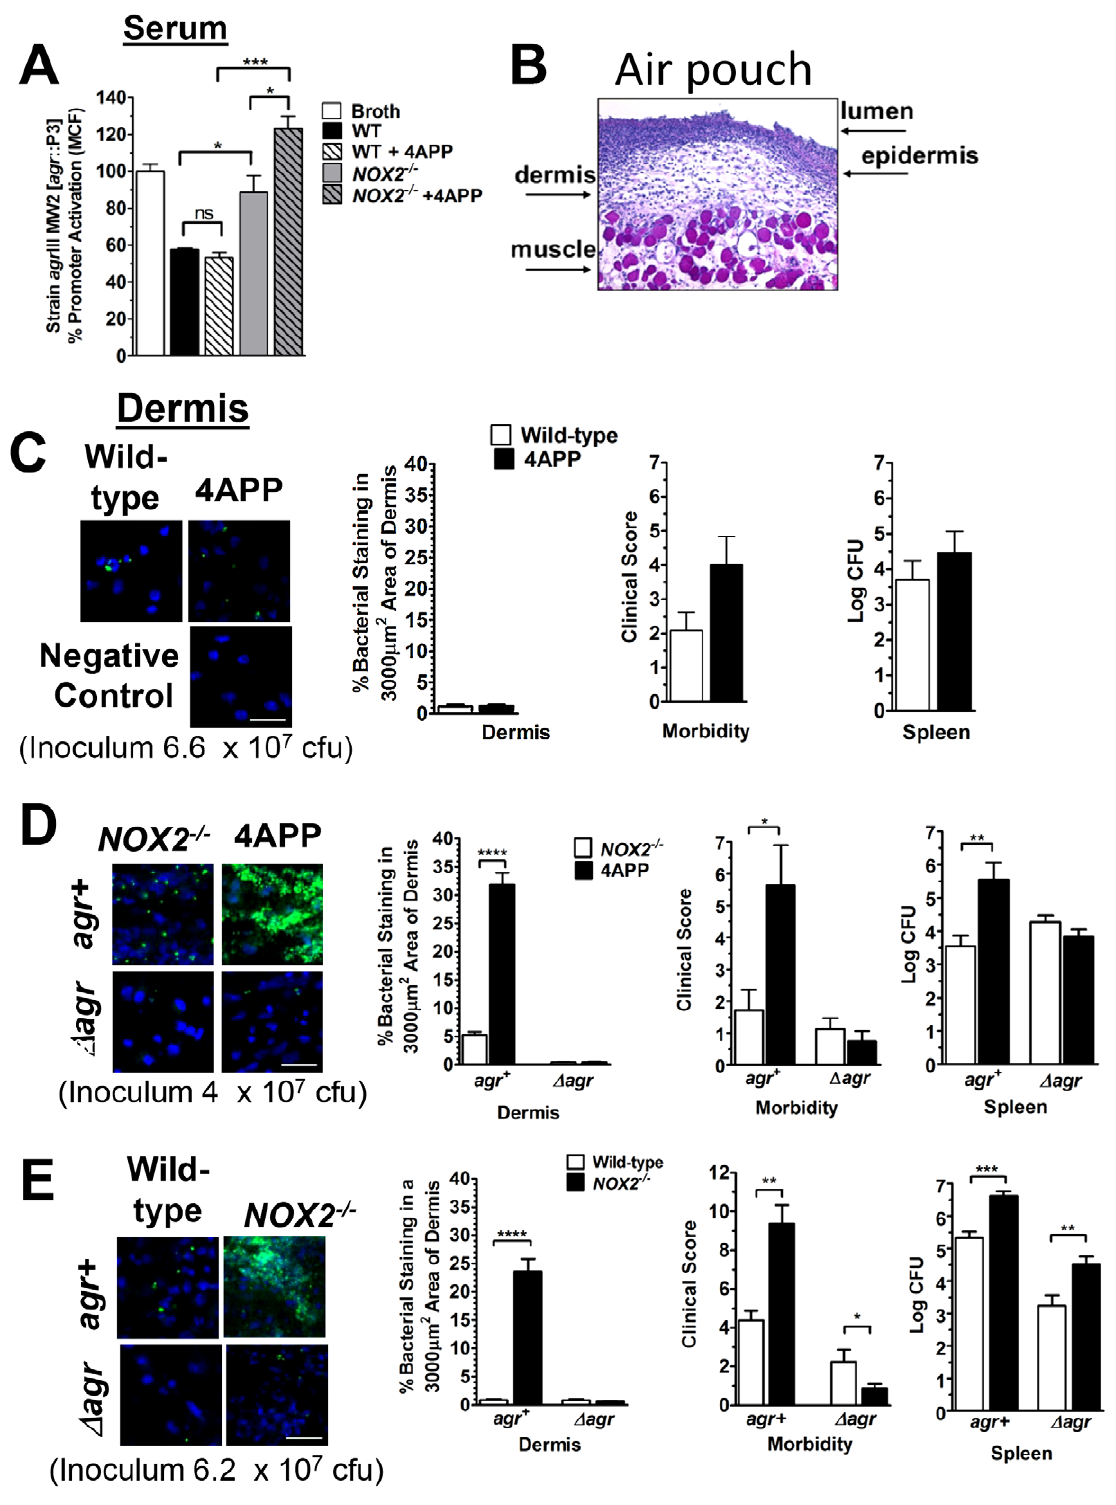
Figure 2. Reduction of serum apoB levels in Nox2 knockout mice but not wild-type mice significantly increases susceptibility to agr III-mediated S.aur eus virulence. (A) Blood was collected from wild-type or Nox2 2 / 2 mice treated with 4APP or vehicle control. After clearing, the serum was heat inactivated and diluted to 10% in TSB for overnight culture with agr III MW2 [ agr ::P3-yfp]. agr ::P3 promoter activation was measured by flow cytometry. Data reported are the mean 6 SEM normalized to broth control at 100%. (B) Air-pouch schematic showing locations of lumen, epidermis, dermis and muscle. (C–E) Air-pouches were generated on the backs of 8 to 12 week old wild-type or Nox2 2 / 2 mice. Where indicated 4APP treated mice were injected i.p. with 100 m l of 5 mg/ml 4APP or vehicle control at 48 h and 24 h prior to infection with MW2 or its agr deletion mutant ( D agr ) at the indicated concentrations. At time zero, air-pouches were injected with early exponential phase MW2. At 28 h post-